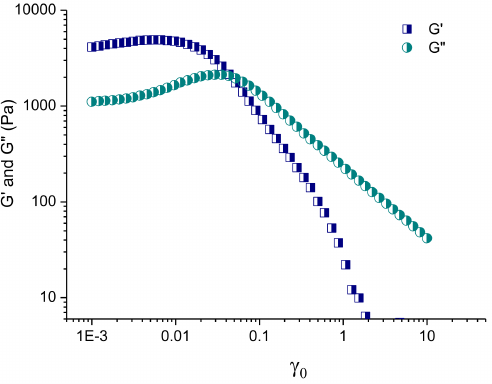
Figure 6. Variation in storage (G (cid:48) ) and loss (G (cid:48)(cid:48) ) moduli as a function of the strain amplitude for niosome-containing in situ gel formulation, G8, at 37 ◦ C.